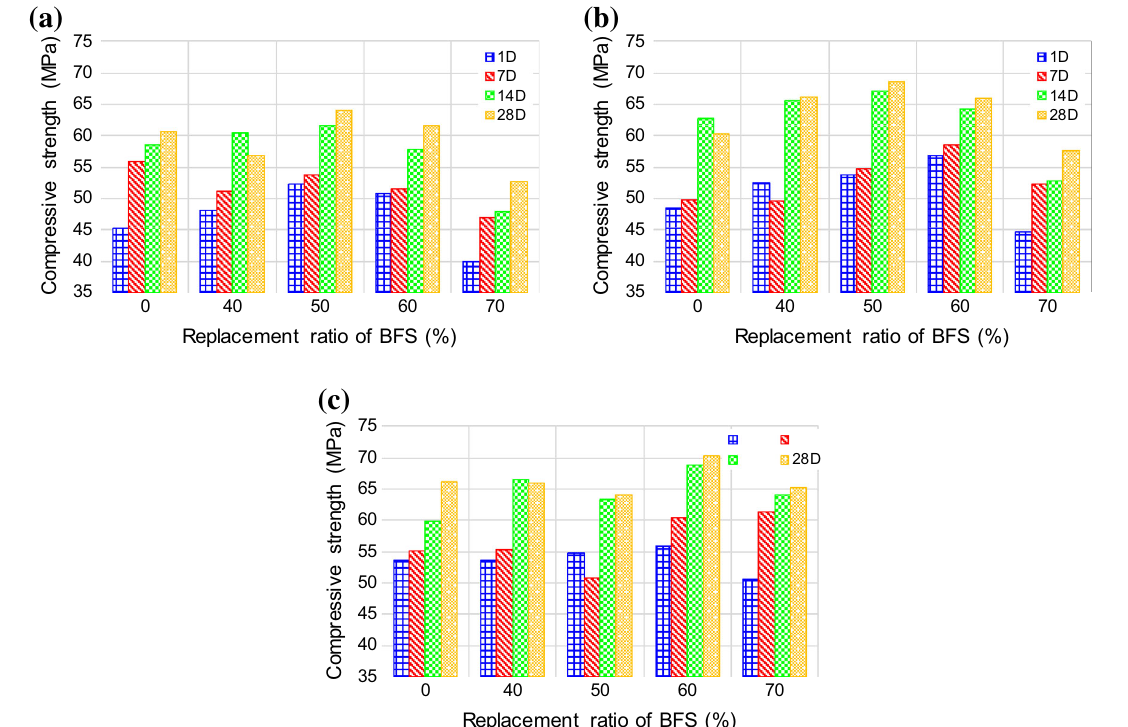
Fig. 6 Effect of replacement ratio of BFS on compressive strength; a W/B of 0.3, b W/B of 0.275, c W/B of